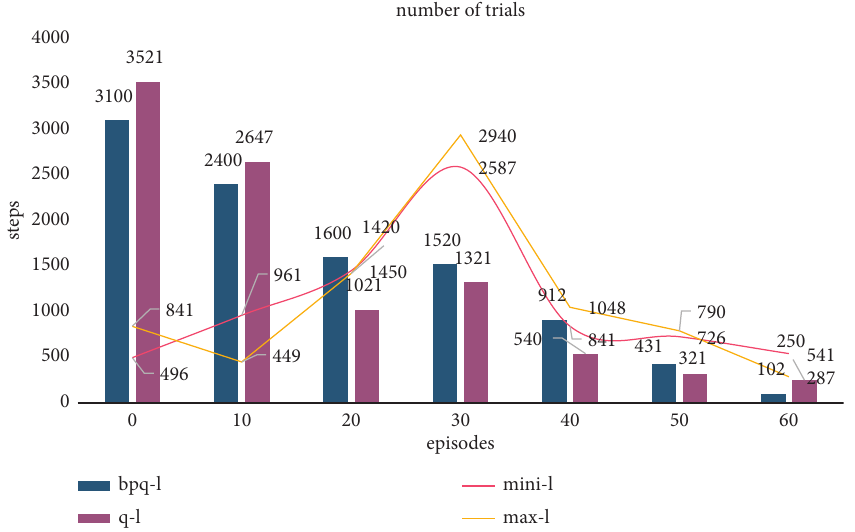
Figure 9: Comparison of trial times between improved Q learning and traditional Q